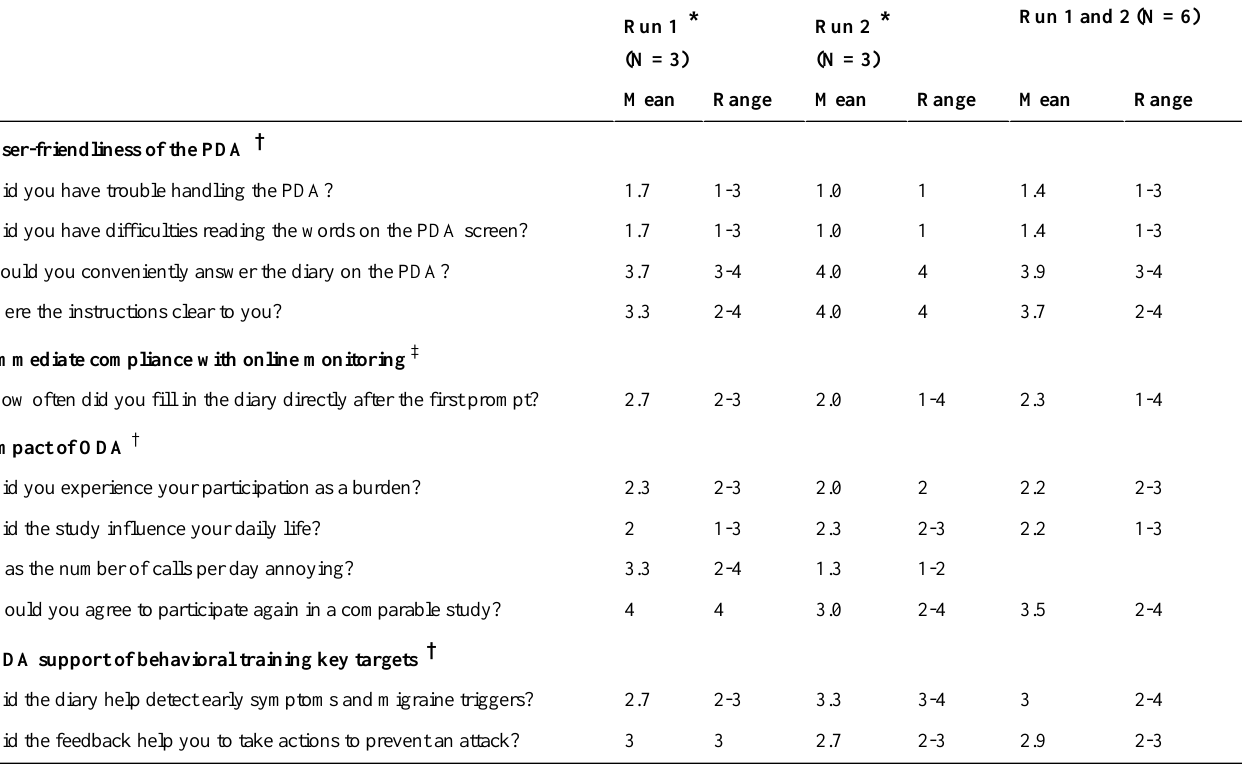
Table 3. Perceived user-friendliness, compliance, impact, and behavioral training support of